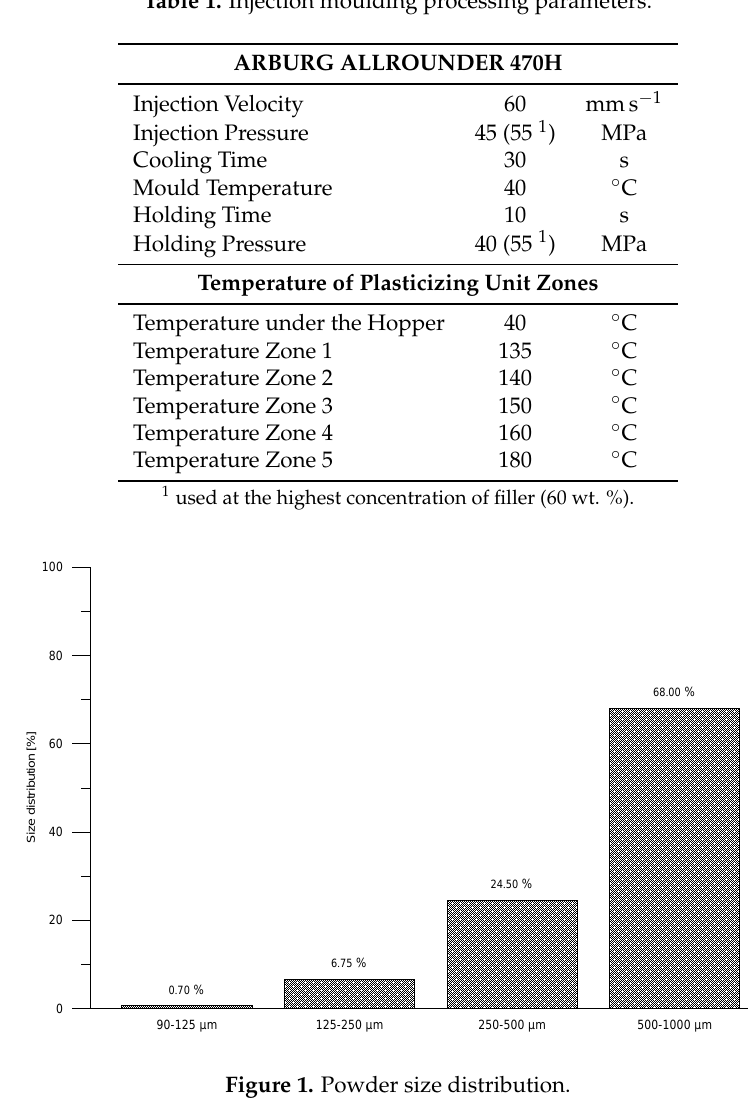
Figure 1. Powder size distribution.